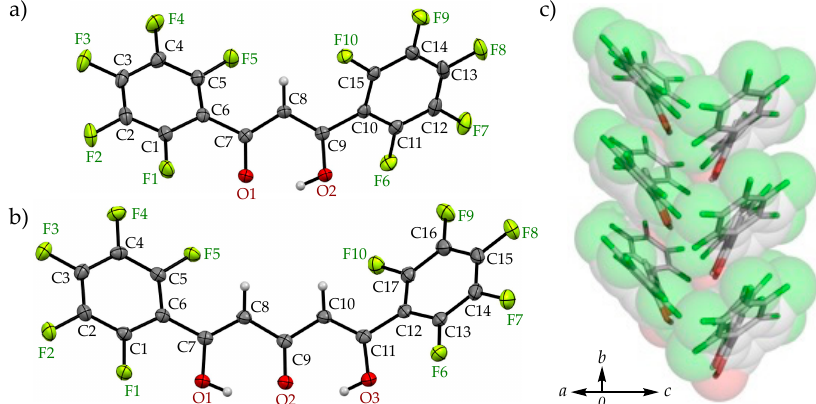
Figure 1. ORTEP drawings of the crystal structure of ( a ) H 1 and ( b ) H 2 2 at 120 K with 50% probability thermal ellipsoids and ( c ) the packing structure of H 2 2 viewed from the ac axis.